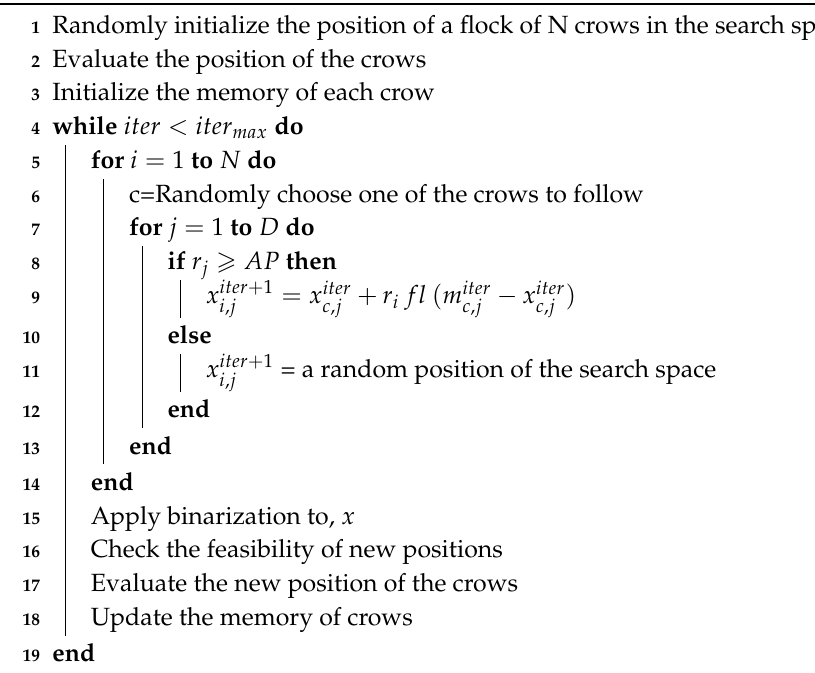
Algorithm 5: CSA + DBscan binarization technique pseudo-code